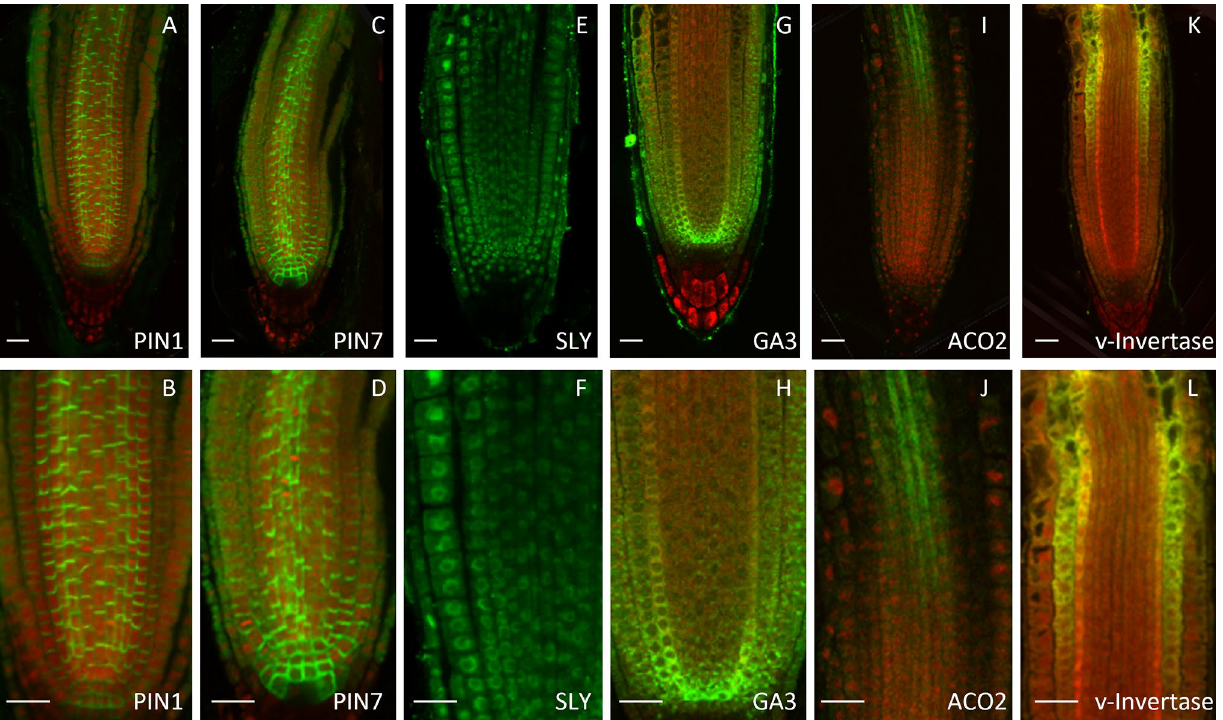
Figure 4. In situ immunodetection of root proteins. Crude ( A – D ) or affinity purified ( E – L ) antisera were used for in situ immunodetection of the target proteins (green) in 4-day old Columbia roots. Primary and Alexafluor 488 coupled secondary antibodies were used at 1:200 dilutions. Seedlings were counter stained using propidium iodide (red). Scale bar 20